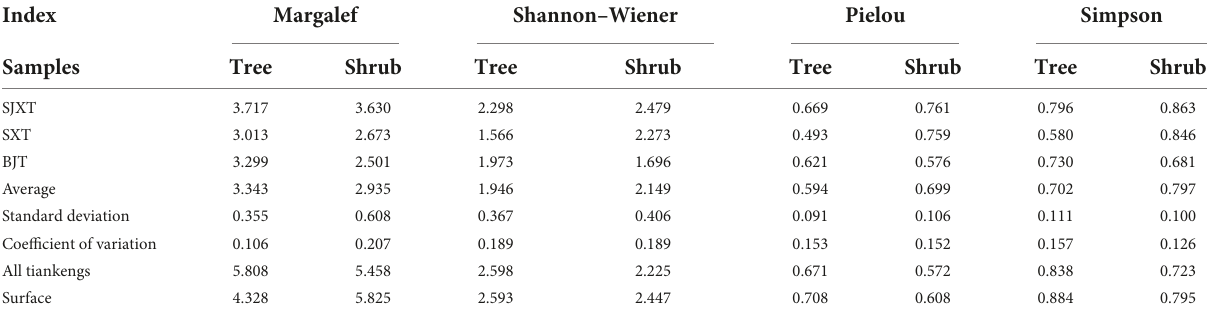
TABLE 4 Diversity of woody layer within the karst tiankengs and